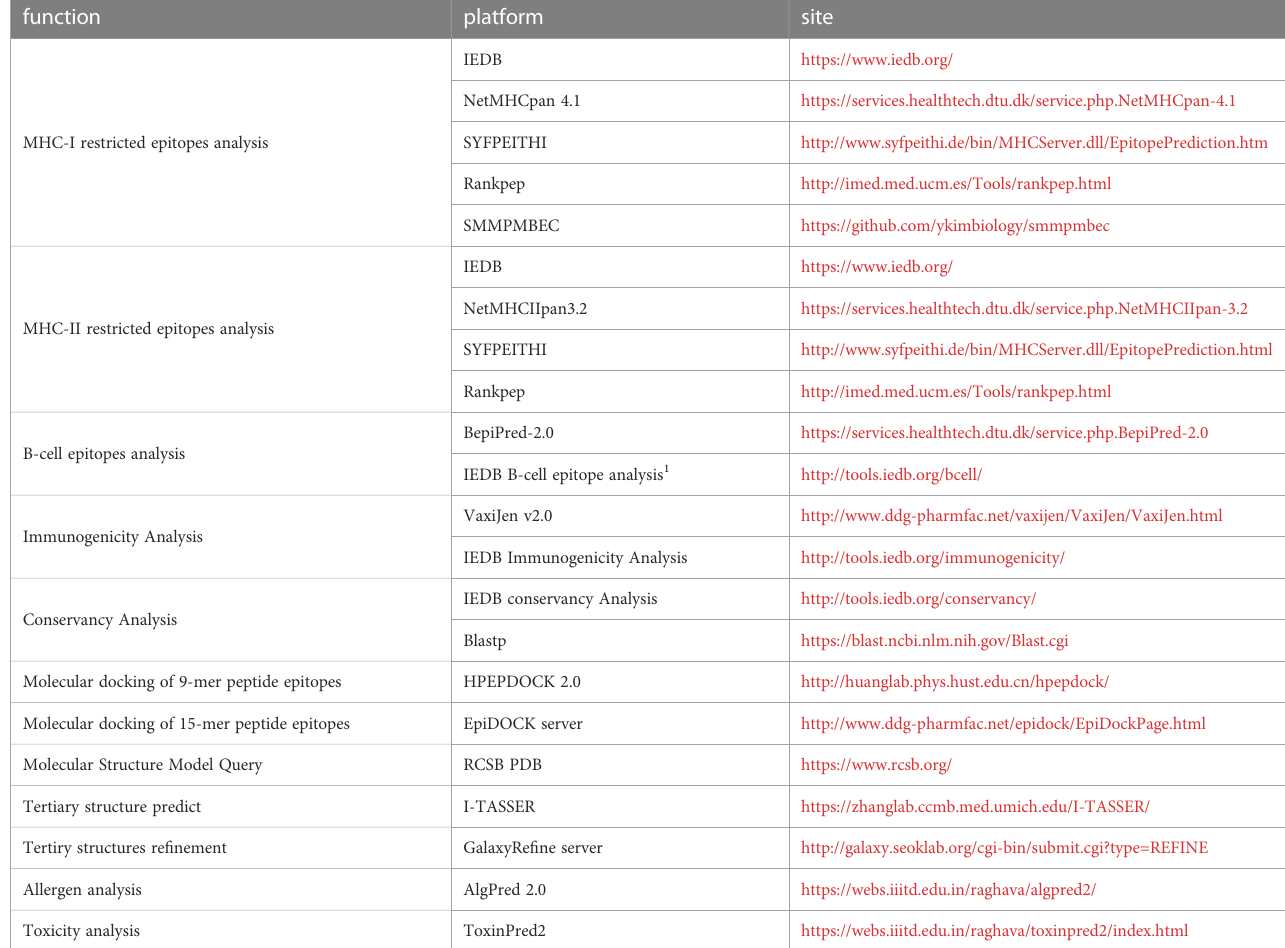
TABLE 1 The various tools involved in the article and their functions, websites. function platform